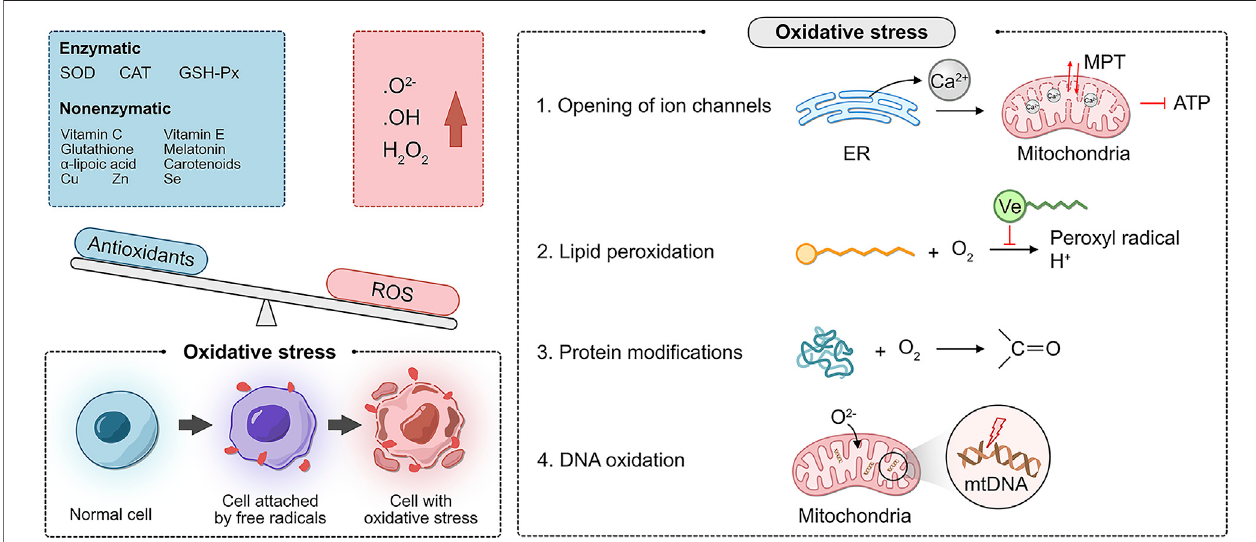
FIGURE 1 | Molecular mechanism of the oxidative stress disorder.